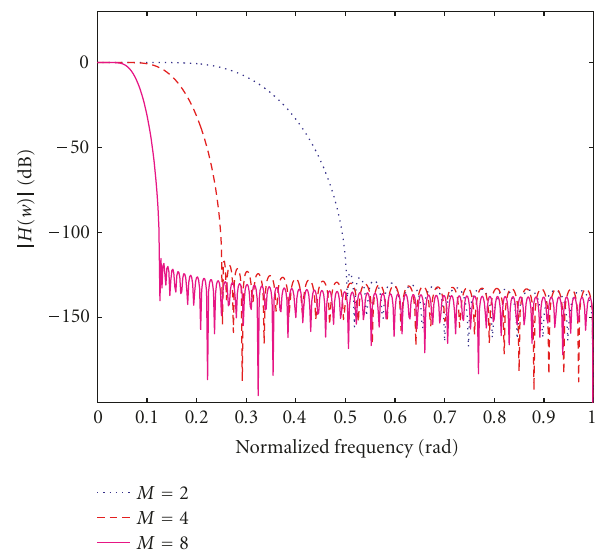
Figure 6: Frequency responses of the prototype filters.